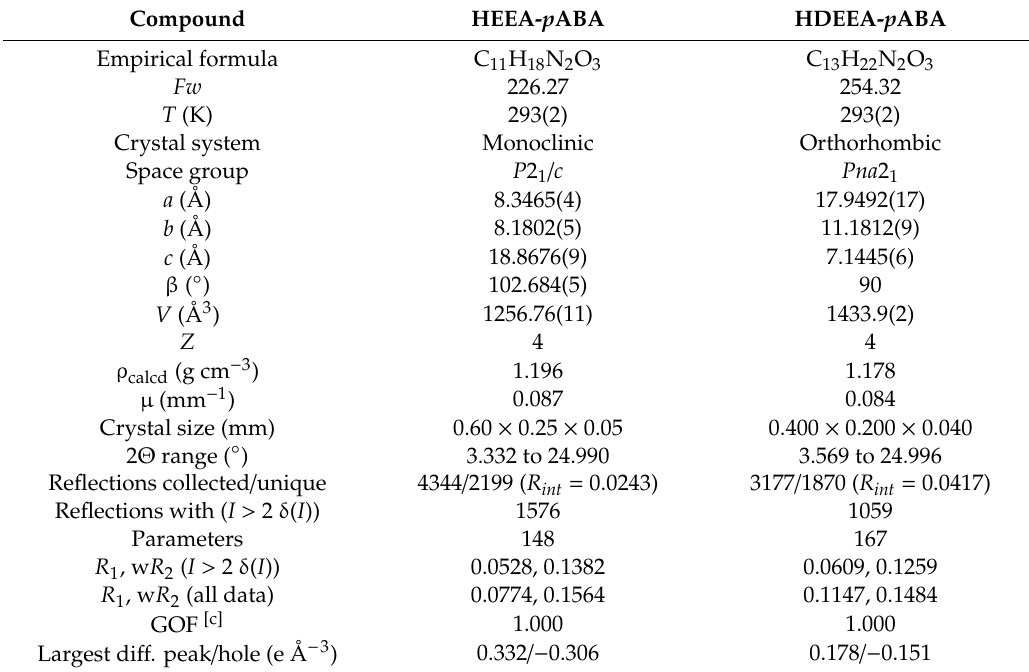
Figure 1. View of the HEEA- p ABA ( a ) and the HDEEA- p ABA ( b ) with partial atomic labelling and charge-assisted hydrogen bonds. Table 1. Crystallographic data and structure refinement details for new compounds.